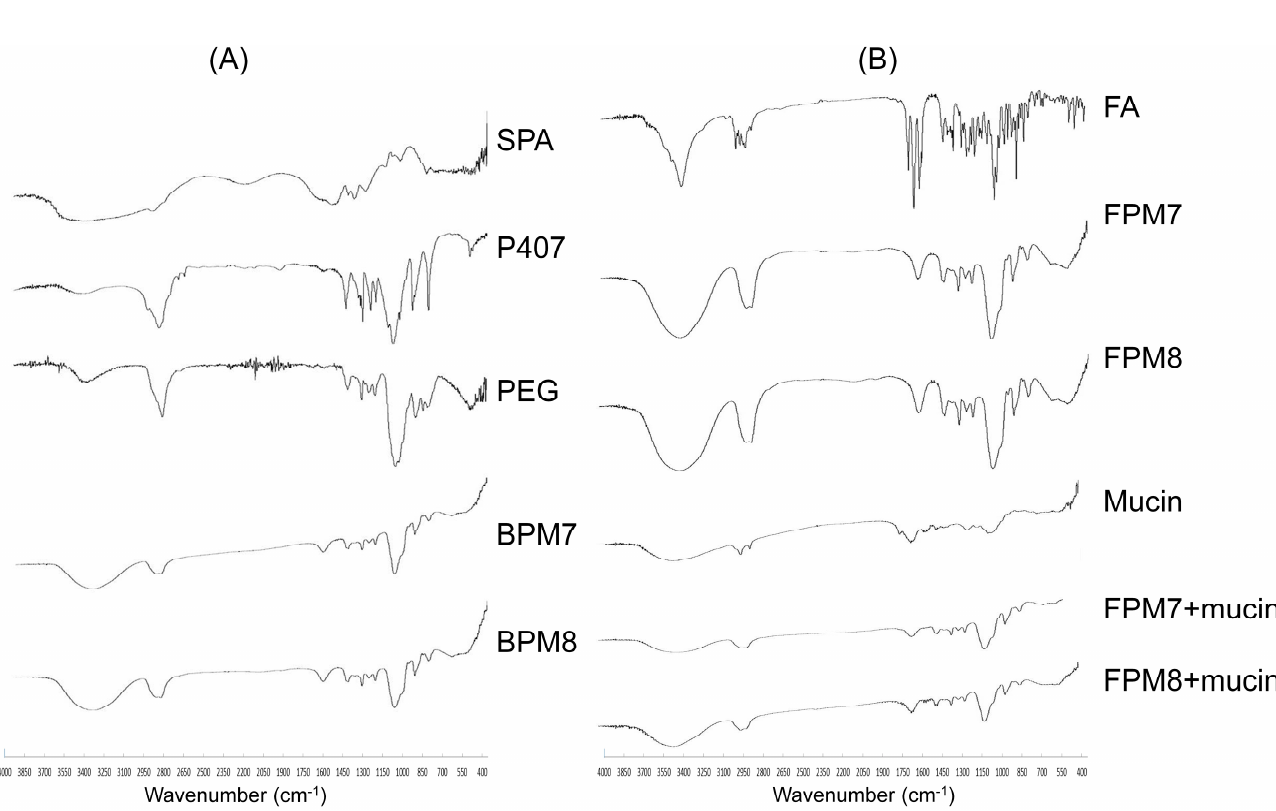
Figure 4. Representative FTIR spectra of ( A ) sodium polyacrylate (SPA), poloxamer 407 (P407), and polyethylene glycol 400 (PEG) compared to the blank polymeric micelles (BPM7 and BPM8) and ( B ) fluocinolone acetonide (FA) compared to FPM7 and FPM8, mucin type II and formulation with mucin.